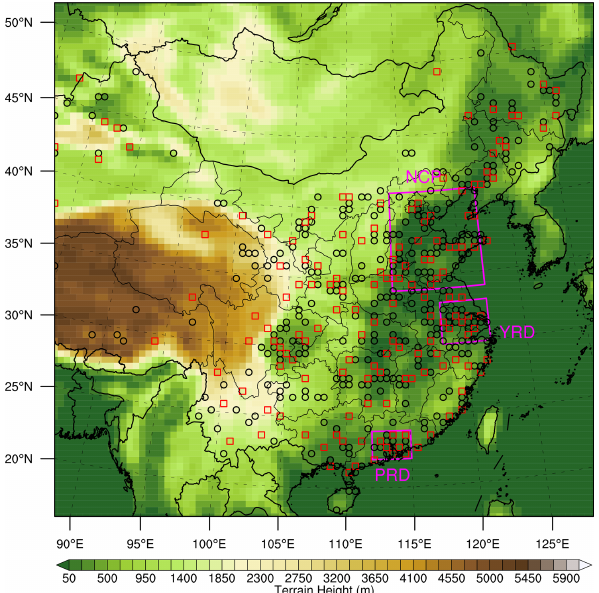
Figure 1. WRF-Chem model computational domain with the to- pography. The locations of the assimilated and independent verifi- cation observation sites of the China National Environmental Mon- itoring Centre (CNEMC) are shown by the black circles and red squares, respectively. The three magenta boxes mark the North China Plain (NCP), the Yangtze River Delta (YRD), and the Pearl River Delta (PRD) subregions, where relatively dense observation sites are